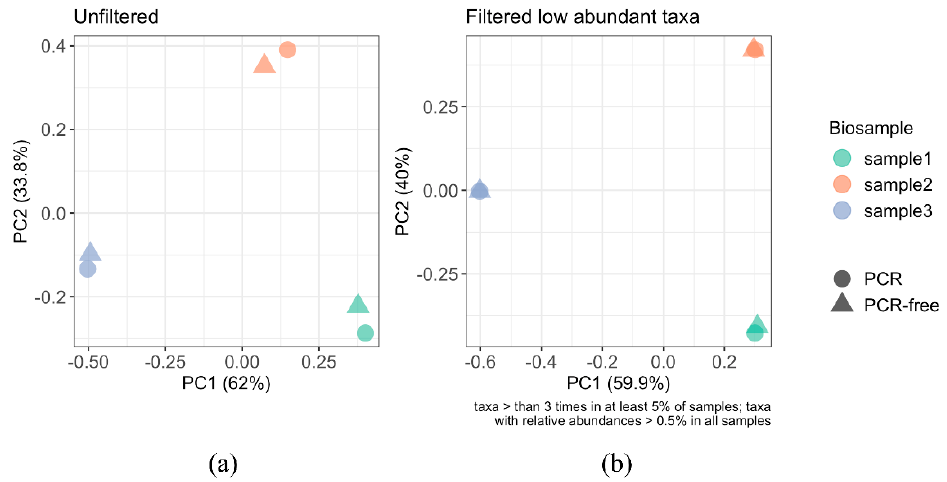
Figure 6. PCoA analysis of the faecal (intestinal) viromes from PCR and PCR-free datasets. The PCoA plots were based on Bray–Curtis distances and were used to interpret the intestinal/faecal virome-derived datasets. ( a ) PCoA of the unfiltered data and ( b ) PCoA plot after removing <0.5% abundant taxa.